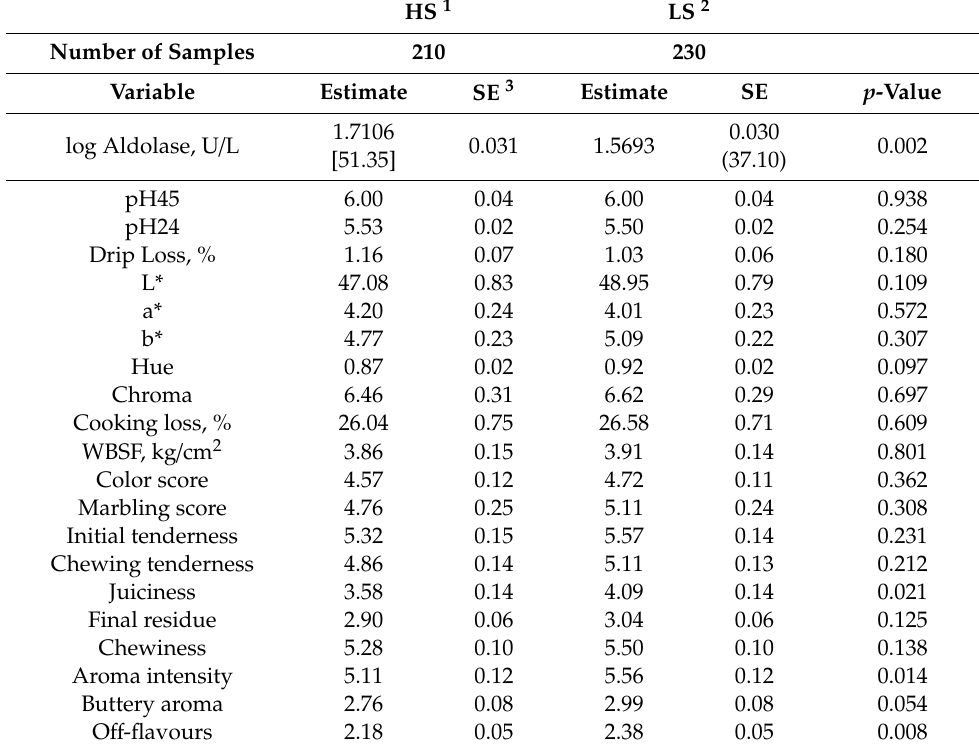
Table 4. Results of the linear mixed-model procedure to identify statistical di ff erences between the two clusters in the measured meat quality parameters and in blood aldolase